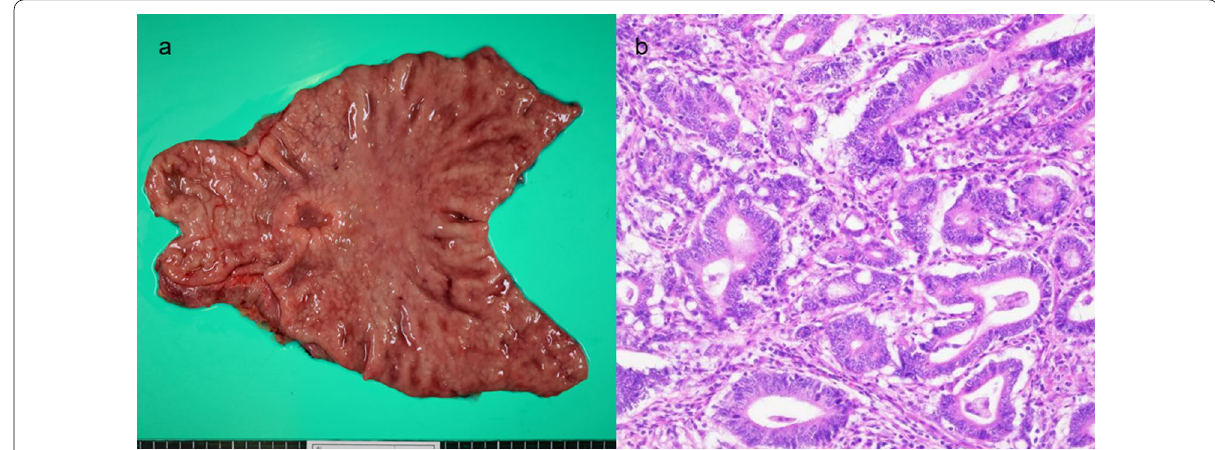
Fig. 4 Resected specimen and pathological findings. a Resected specimen. Borrmann type 3 cancer was found in the lesser curvature of the antrum. b Pathological findings. Well- to moderately differentiated adenocarcinoma invading the subserosal layer (hematoxylin and